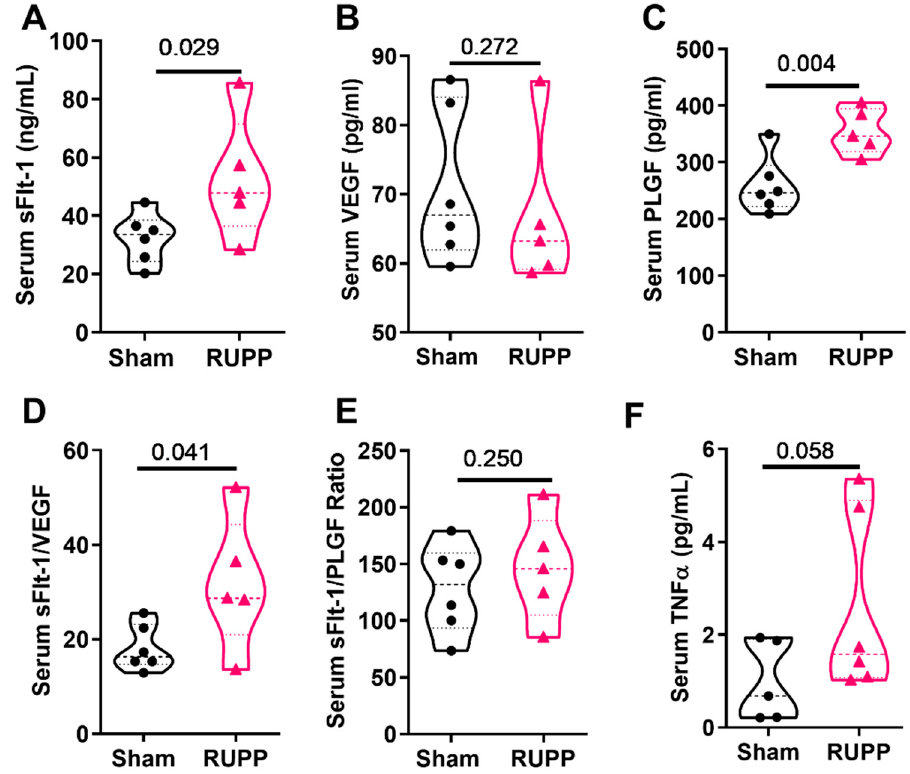
Figure 1. RUPP in the mouse induces some similar changes in angiogenic factors to the rat and preeclampsia patient. RUPP-induced ( A ) increased sFlt-1, ( B ) no change in VEGF, ( C ) increased PlGF, ( D ) increased sFlt-1/VEGF ratio, and ( E ) no change in sFlt-1/PlGF ratio in serum samples compared to sham controls. ( F ) Trend for increased TNF α levels in RUPP mice. Sham n = 6 mice and RUPP n = 5. Data analyzed using unpaired t -test. Points indicate values for individual dams. SFlt—soluble Fms-like tyrosine kinase 1; VEGF—vascular endothelial growth factor; PLGF—placental growth factor.